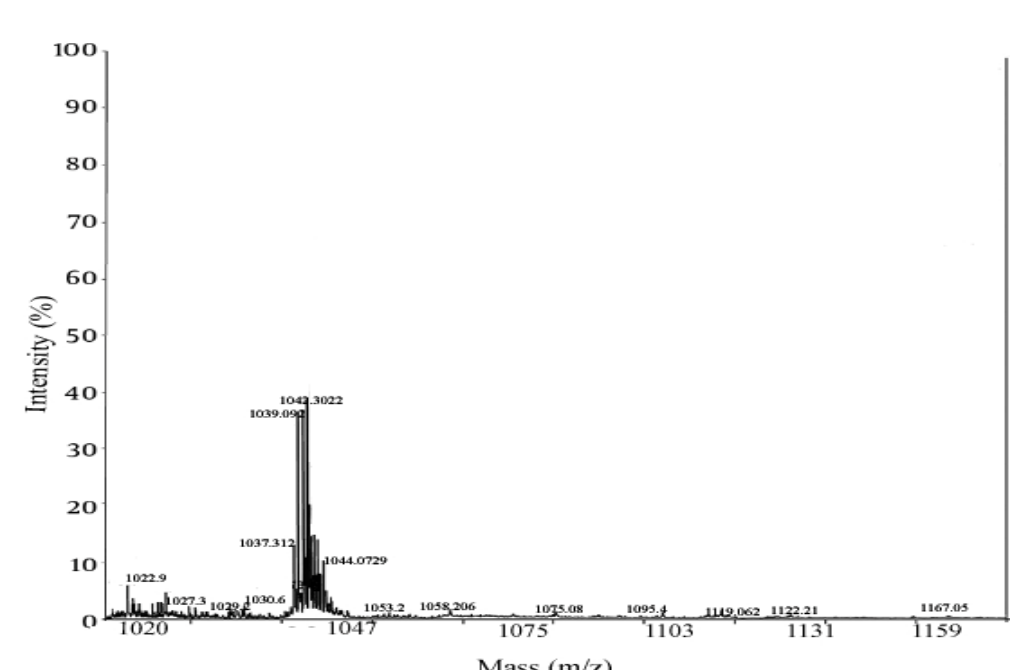
Figure 6. Nuclear magnetic resonance spectra of surfactant purified from Bacillus subtilis strain Al- Dhabi-130.